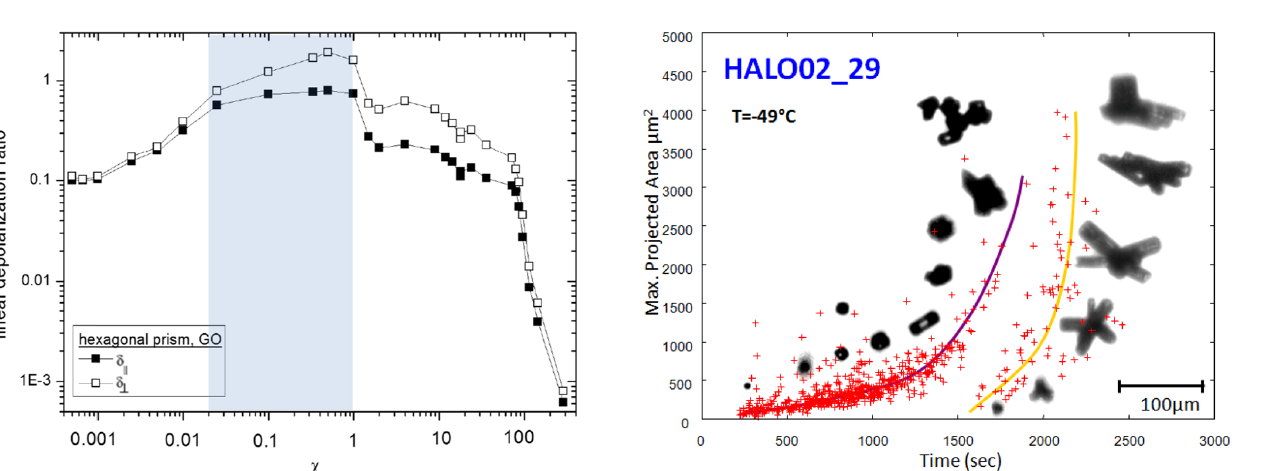
Fig. 12. Linear depolarization ratios vs. χ of randomly oriented hexagonal prisms calculated using geometric optics. The shaded area represents the wide range of aspect ratios which was deduced from the HOLIMO and PHIPS images throughout HALO02 18 experiment.